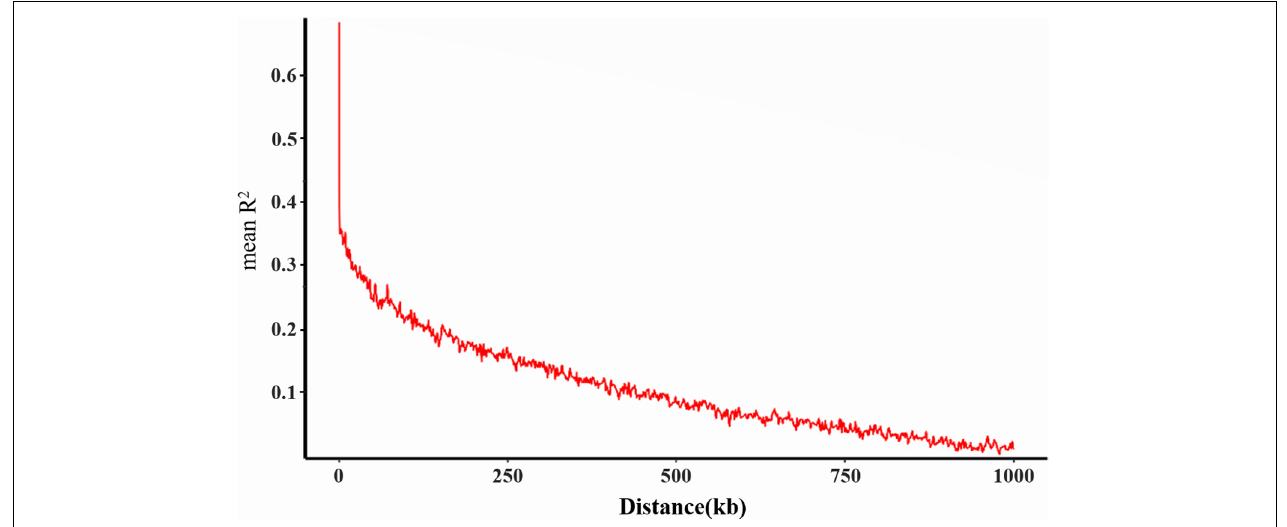
FIGURE 3 | Genome-wide linkage disequilibrium (LD) decay for all 260 accessions. R 2 indicates the squared allele frequency correlations between all pairs of SNP markers. The X -axis indicates the distance between marker pairs.